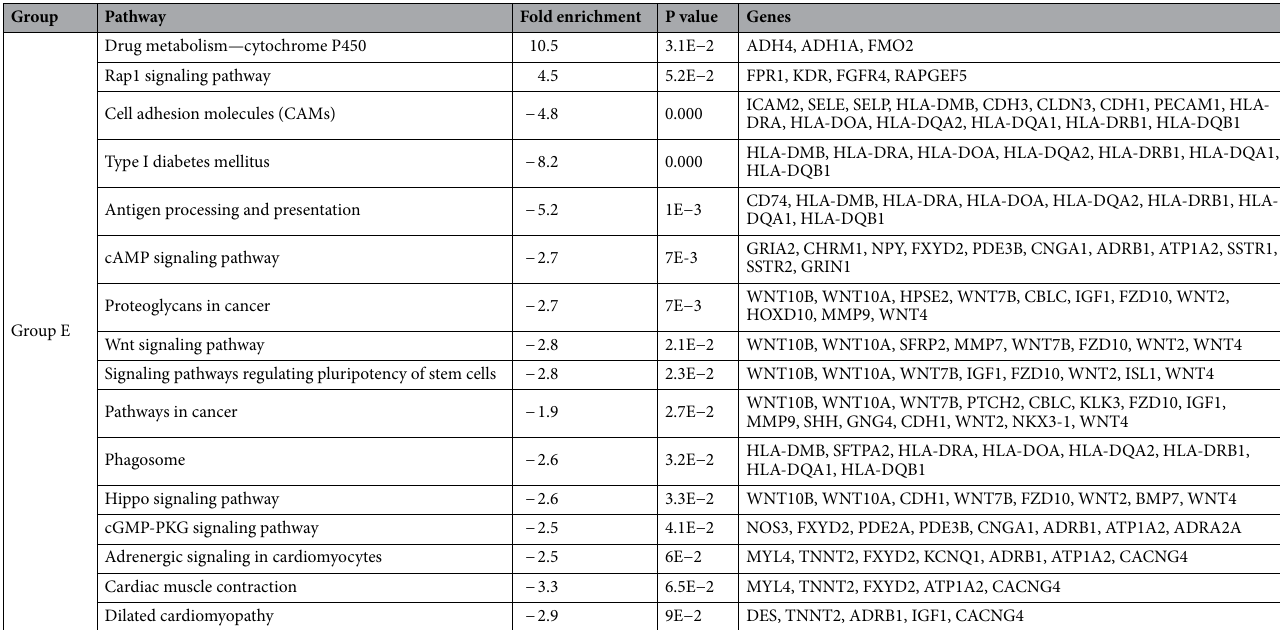
Table 1. List of enriched up/down-regulated pathways. Group A: DEGs between DEX and ETH treated for short duration (16 h); Group B: DEGs between DEX and ETH treated for longer duration (7 d); Group C: DEGs that overlapping between Group A and Group B; Group D: Uniquely expressed DEGs of HTM cells exposed for 16 h (Group A minus Group C); Group E: Uniquely expressed DEGs of HTM cells exposed for 7 d (Group B minus Group C).